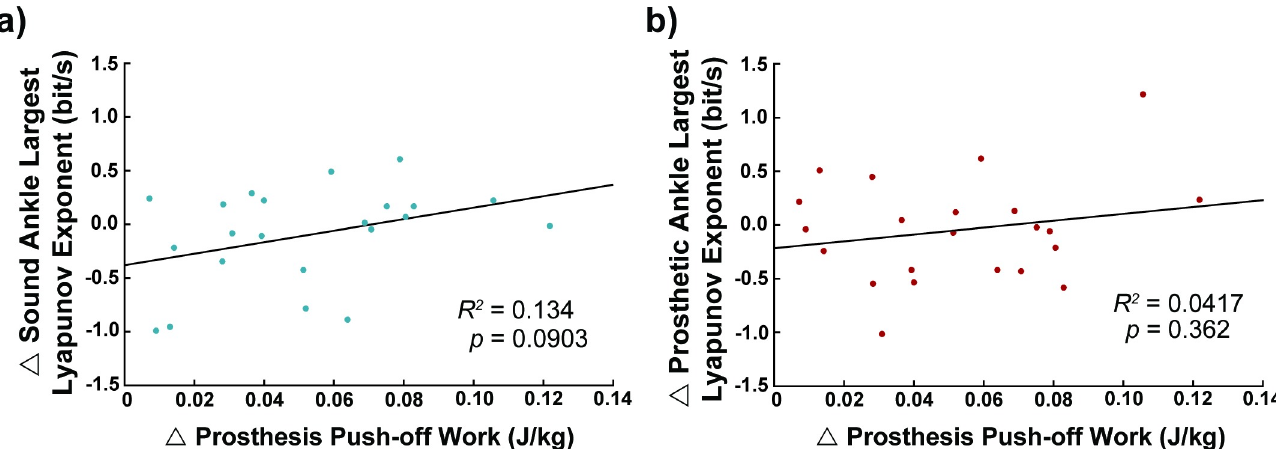
Fig 4. Changes in prosthesis push-off work did not correlate with stride-to-stride fluctuation changes within individuals at the sound ankle (a, R 2 = 0.134, n = 22, p = 0.0903) or the prosthetic ankle (b, R 2 = 0.0417, n = 22, p = 0.362). As stride-to-stride fluctuations result from the interaction of various systems including neural, mechanical, and (in this case) synthetic, we expected that changes to the prosthesis mechanics would result in changes in the stride-to-stride fluctuations. The lack of relation indicates that the mechanical contribution of the limb to stride-to-stride fluctuations may not be a significant contributor. ( Δ = High Activity prosthesis value–Low Activity prosthesis